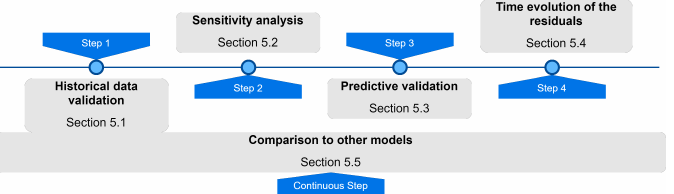
Figure 12. Workflow of the proposed techniques for the verification and validation of ML models for dam behaviour